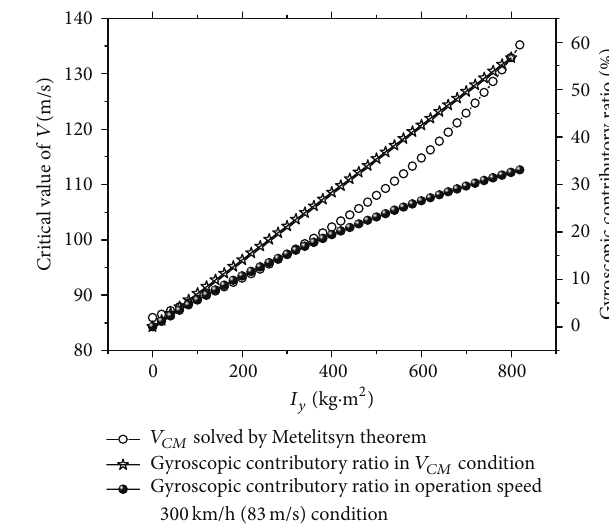
Figure 7: Influence of 𝑘 𝑦 on 𝑉 𝐶𝑀 and GOR.